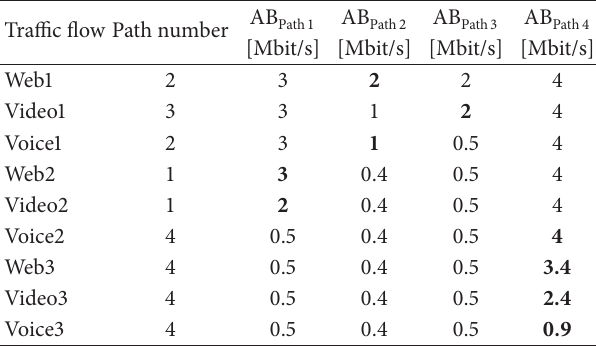
Figure 6: Simulation model. Table 4: The path selection and the available bandwidth of the paths using WSP.